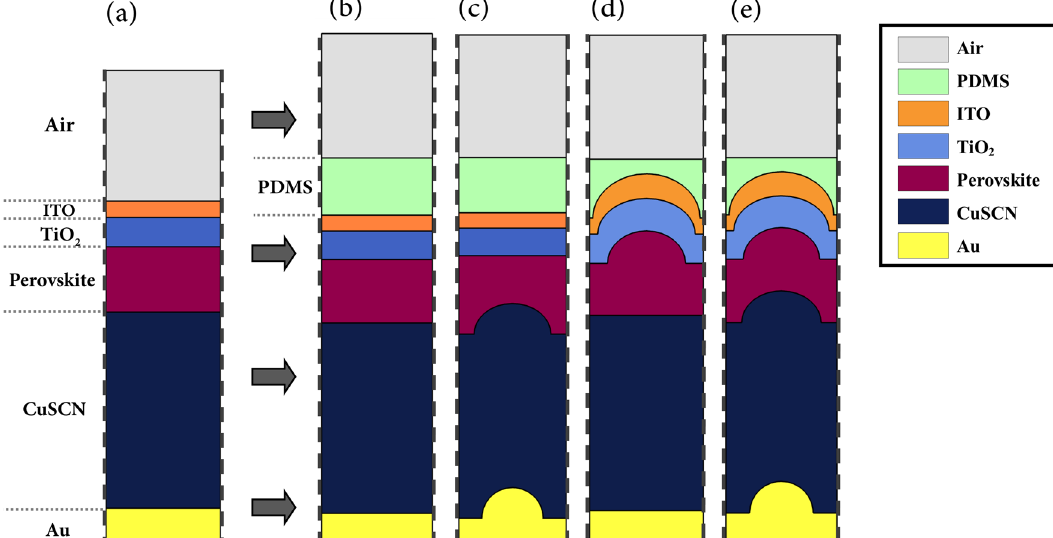
Fig. 3. Schematic of the planar and proposed light-trapping structures. The width of the simulated unit cell is 350 nm. The curved Au in (c,e) is a semi-circle with a radius of 100 nm. All other convex nanostructures are semi-ellipses. The curved HTL in (c,e) has a minor radius of 100 nm and a major radius of 110 nm, the curved perovskite has a minor radius of 100 nm and a major radius of 120 nm, the curved ETL has a minor radius of 110 nm and major radius of 150 nm, and the curved ITO has a minor radius of 135 nm and major radius of 165 nm.